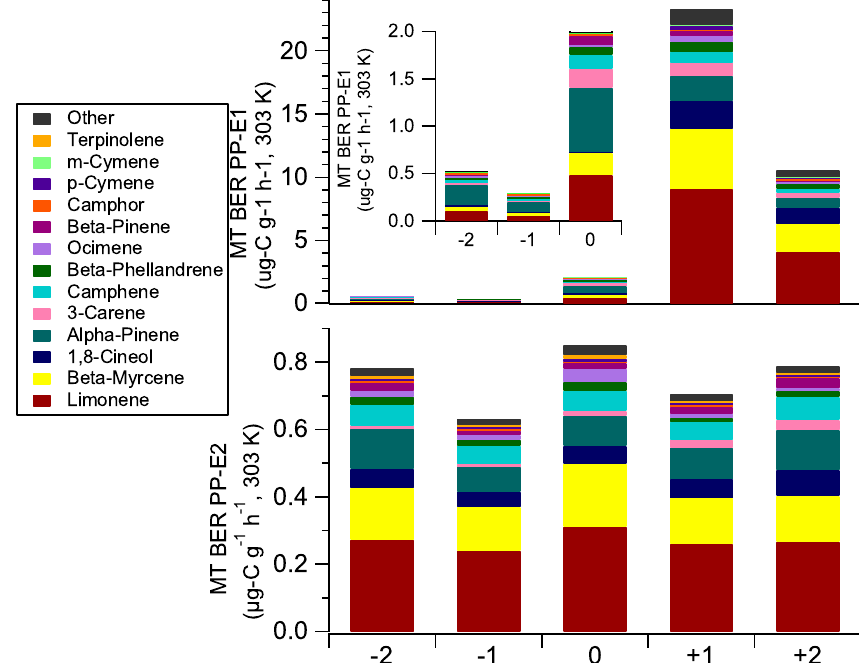
Figure 3. Summary of monoterpenoid profile for the two Picea pungens methyl jasmonate (MeJA) experiments. The x axis denotes the day relative to treatment, where treatment was performed on day 0. The y axis is the monoterpenoid (MT) basal emission rate normalized to 303K. Results from the methyl jasmonate (MeJA) experiment performed in May are presented in the top plot and the results from the MeJA experiment performed in July are presented in the bottom plot. Note the difference in y axis scale for the top plot vs. the bottom plot. The inset in the top plot is provided as an enlargement of the profiles for days − 2, − 1, and 0 for experiment